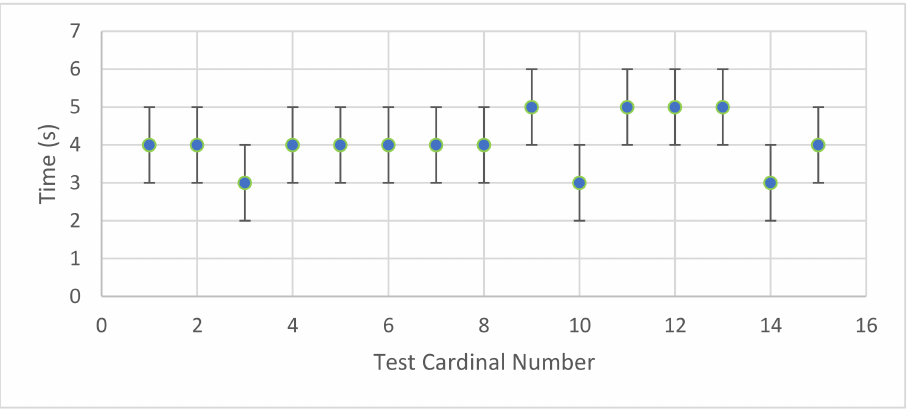
Figure 14. The minimum distance between the ULD and the HMI beyond which the connection between the two modules is lost.